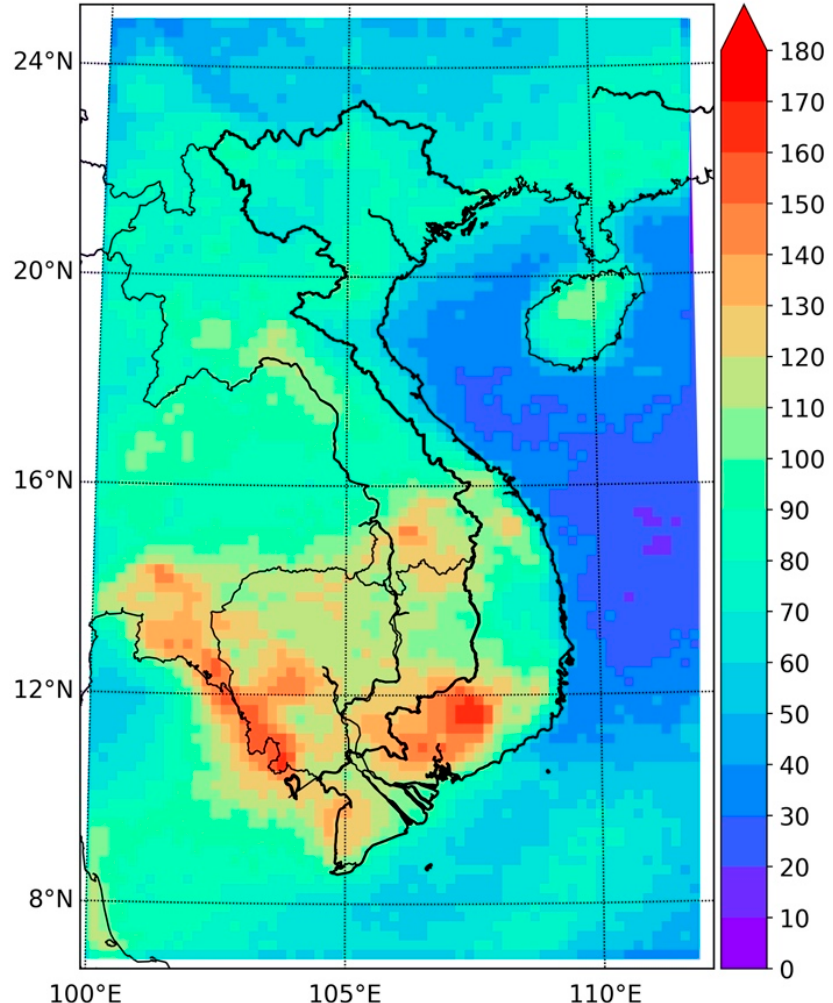
Figure 8. The average annual number of thunderstorm days in Vietnam in 2015–2019 based on GLD360 data.